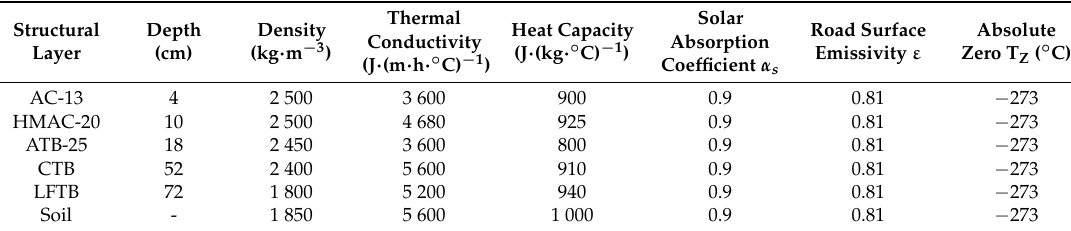
Table 7. Temperature parameters of HMAC pavement.